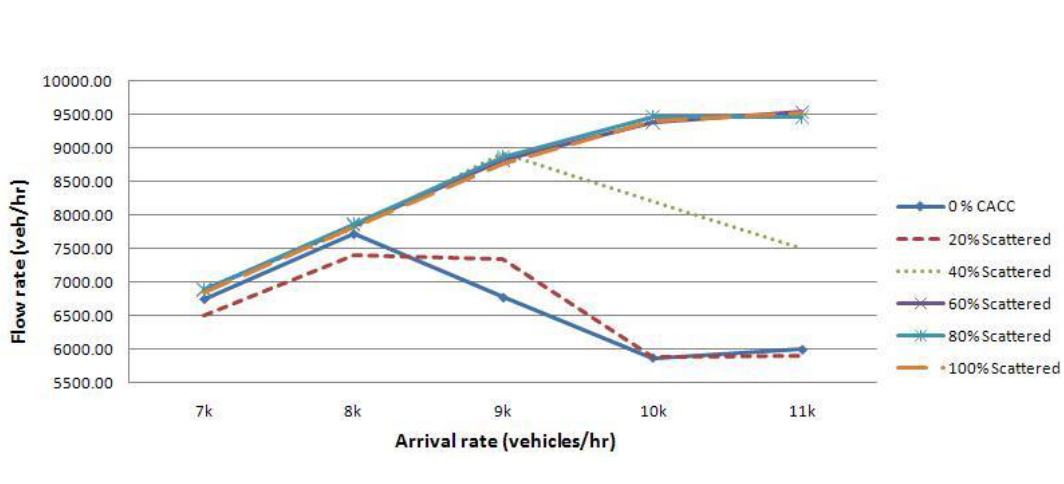
Figure 9. Flow rate analysis (without a